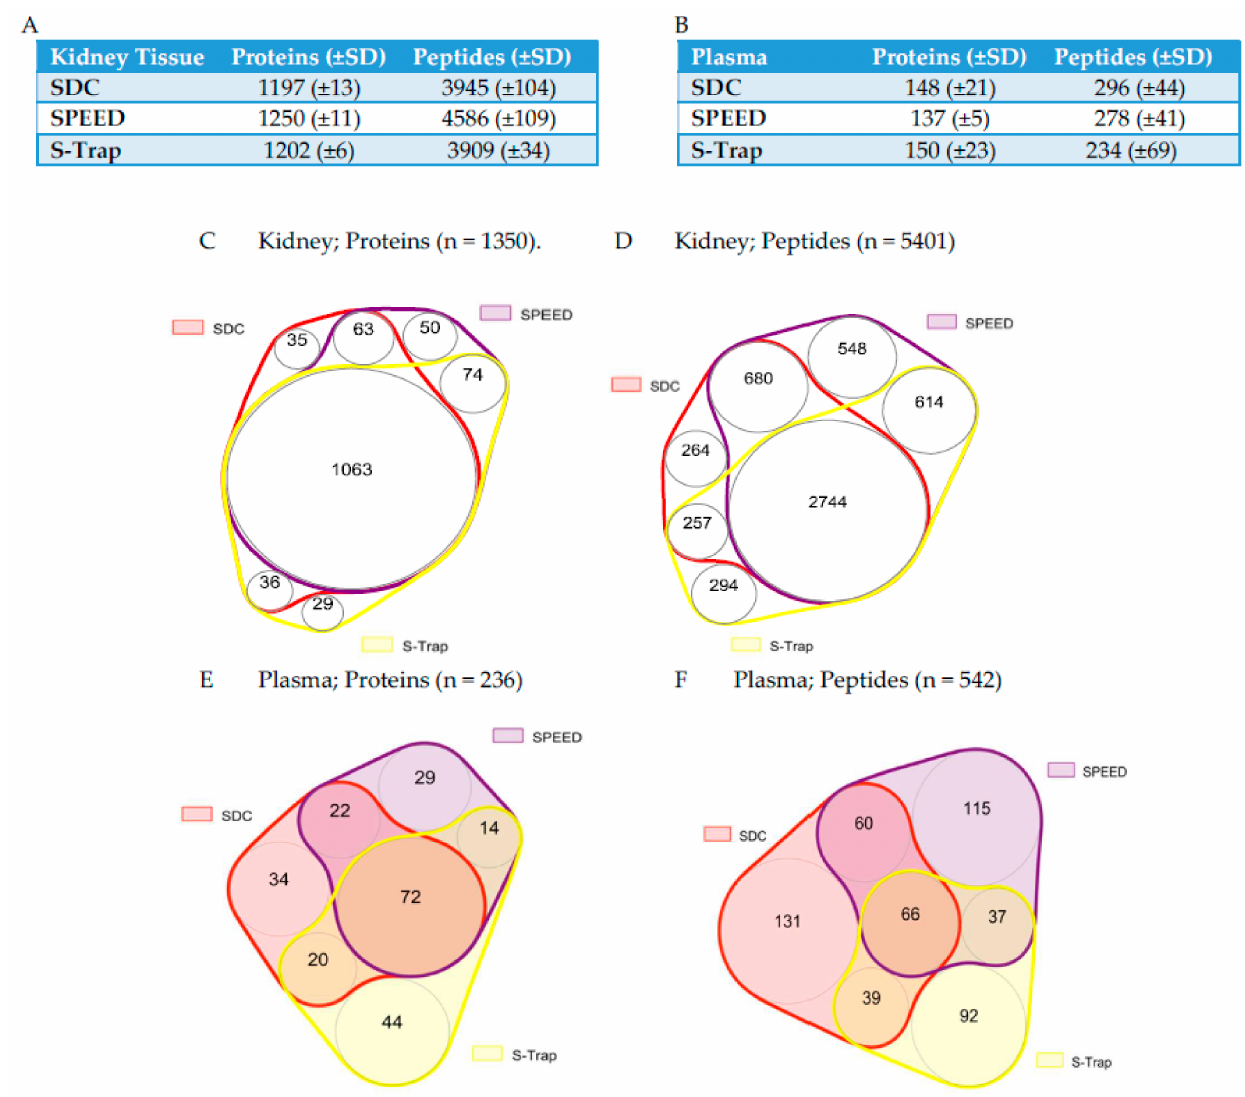
Figure 1. Summary tables ( A ) and proportional Venn diagrams ( B ) indicating the number of ( C ) pro- teins and ( D ) proteins quantified in kidney tissue, and number of ( E ) proteins and ( F ) peptides quantified in plasma by each preparation method using SWATH-MS. Areas of overlap indicate proteins/peptides quantified in SWATH by more than one preparation